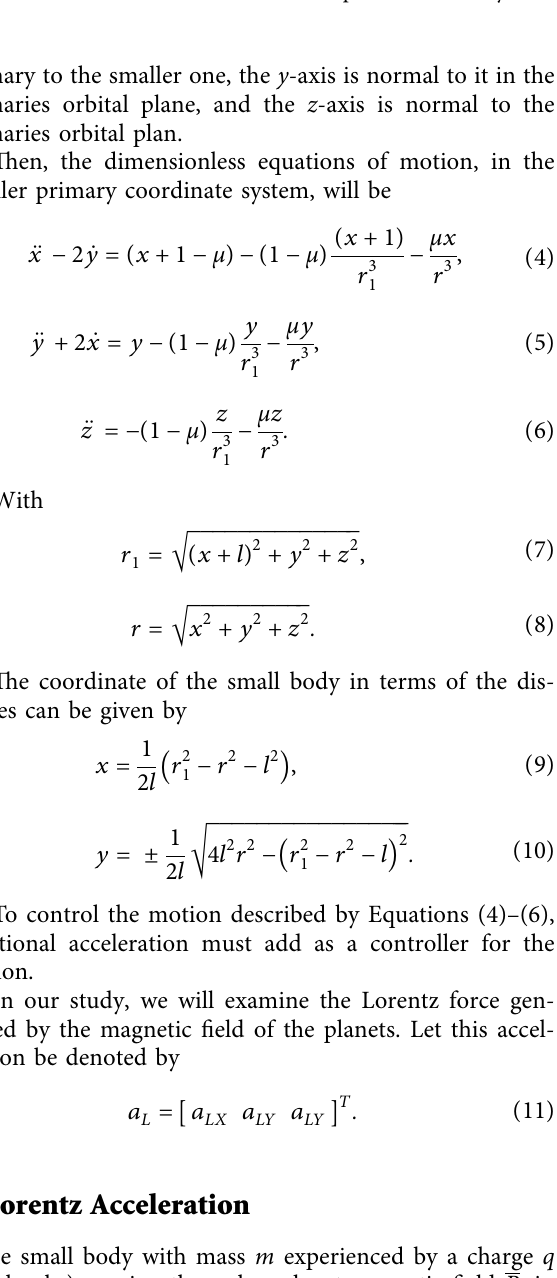
Figure 1: The kinematics of circular planer three